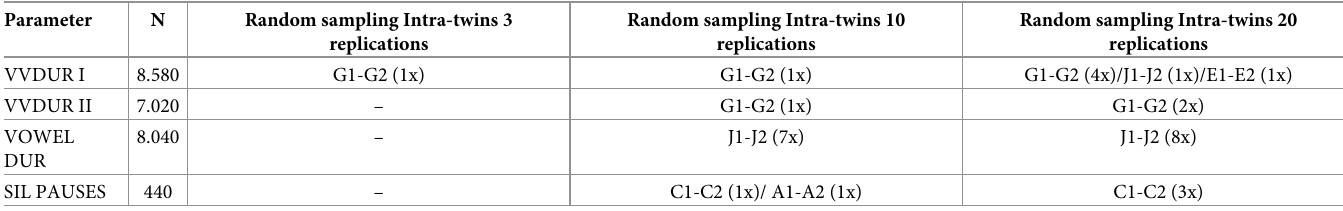
Table 3. Number of significant differences (Dunn’s Multiple Comparison Test, df = 19, two-tailed test, p < 0.025 with Bonferroni adjustment) in intra-twin pair comparisons for VVDUR I, VVDUR II, VOWEL DUR, and SIL PAUSES for downsized